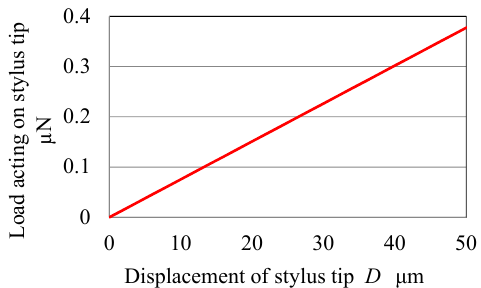
Figure 9. Experimental apparatus for measurement of surface force.